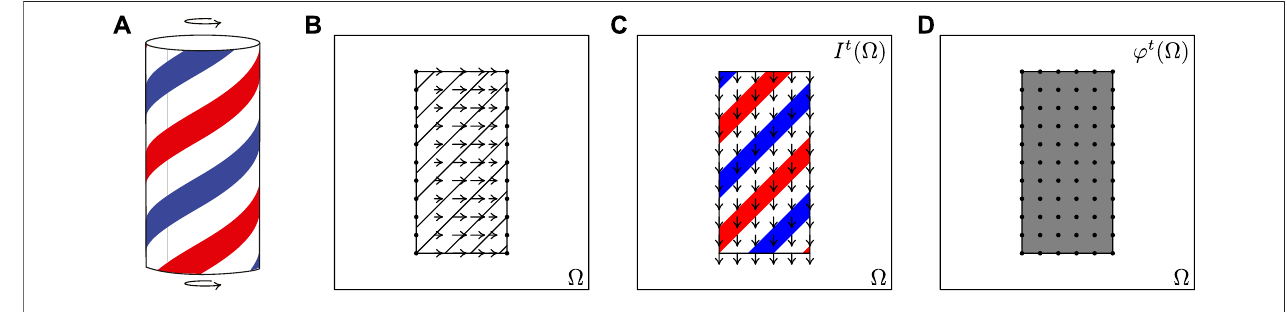
FIGURE1| Barber ’ spoleexample. (A) The3-Dobjectspinningcounterclockwise. (B) The2-Dprojectionofthepoleandtheprojectedvelocityontheretina Ω . (C) The brightness of the image and its optical fl ow pointing downwards. (D) A feature map that responds to the object and its conjugate (zero) optical fl